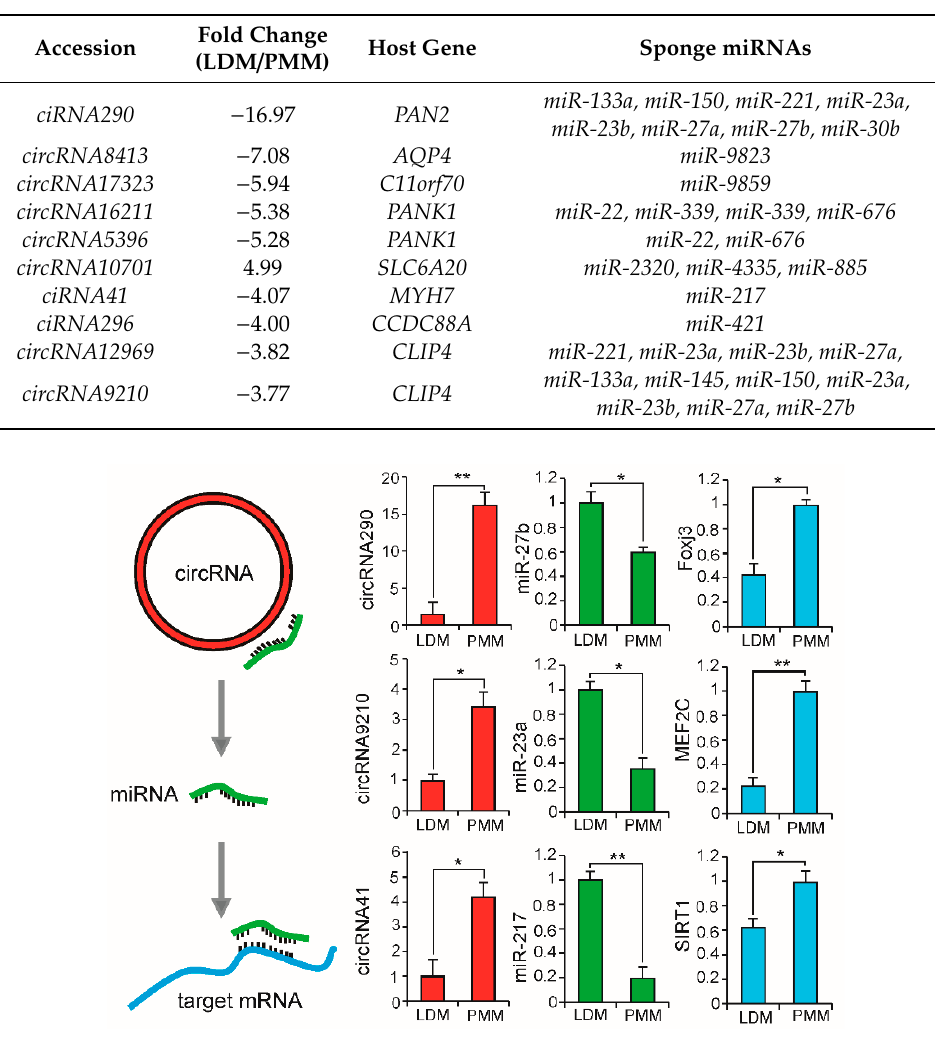
Figure 8. The di ff erentially expressed circRNA-miRNA-mRNA network between LDM and PMM. qPCR was used to detect expression levels of circRNAs, miRNAs, and mRNAs. All data are presented as means ± SEM. Student’s t -test used to calculate statistical significance (* p < 0.05, ** p < 0.01), n =